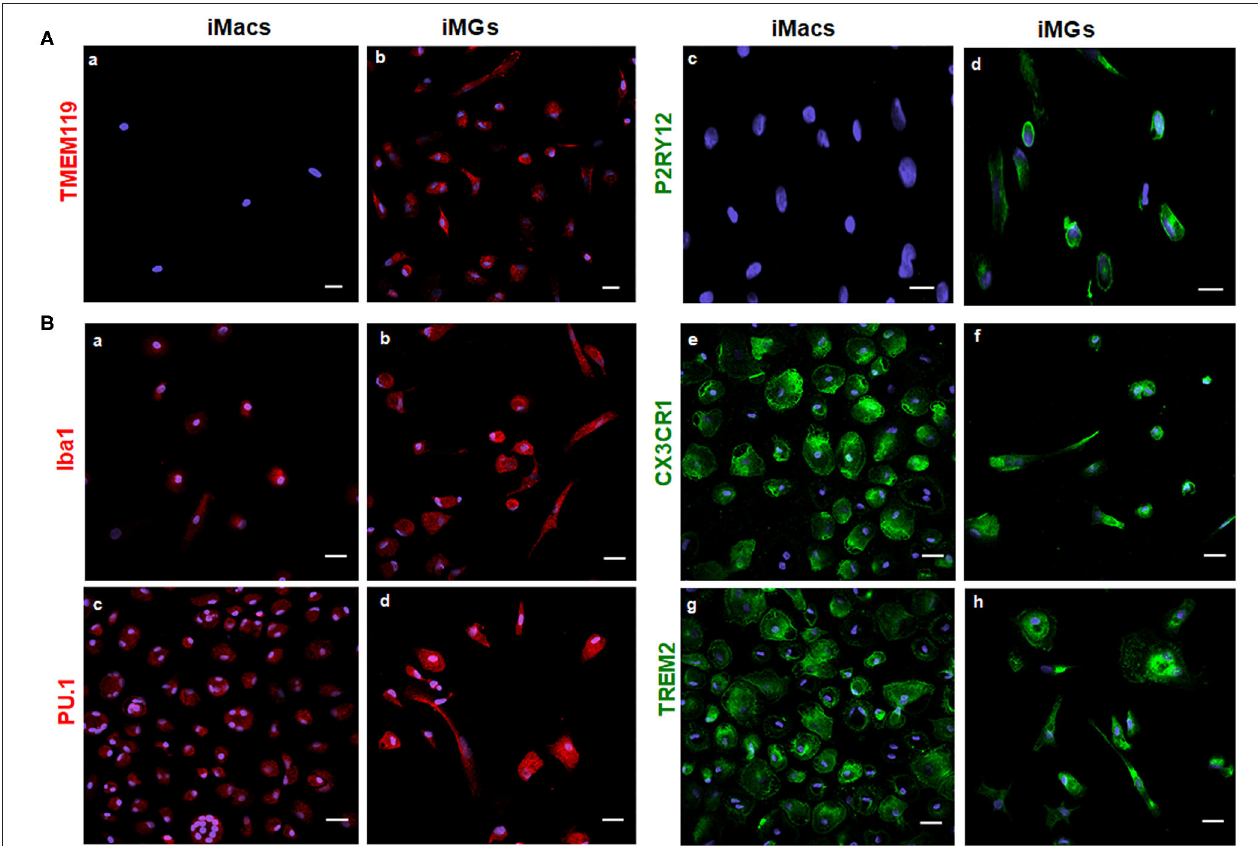
FIGURE 2 | iMG cells expressed microglia-specific markers (TMEM119 and P2RY12) and other myeloid-specific markers. The expression of surface markers on the iMG cells and iMacs were performed by immunocytochemistry. Peripheral monocytes were incubated with GM-CSF (iMacs) for 5–7 days or cocktail of GM-CSF and IL-34 (iMG cells) for 10–14 days. Representative images of iMacs and iMG cells were shown. (A) iMG cells expressed unique microglial markers TMEM119 (b) and P2RY12 (d), which were absent from iMacs (a,c). (B) Myeloid lineage markers were expressed on both iMacs and iMG cells, such as Iba1 (a,b), PU.1 (c,d), CX3CR1 (e,f), and TREM2 (g,h). Images were captured at 40 × with a scale representing 20 µ m, where P2RY12, CX3CR1, and TREM2 were stained green, TMEM119, Iba1, and PU.1 were stained red. Cellular nuclei were stained blue with DAPI.